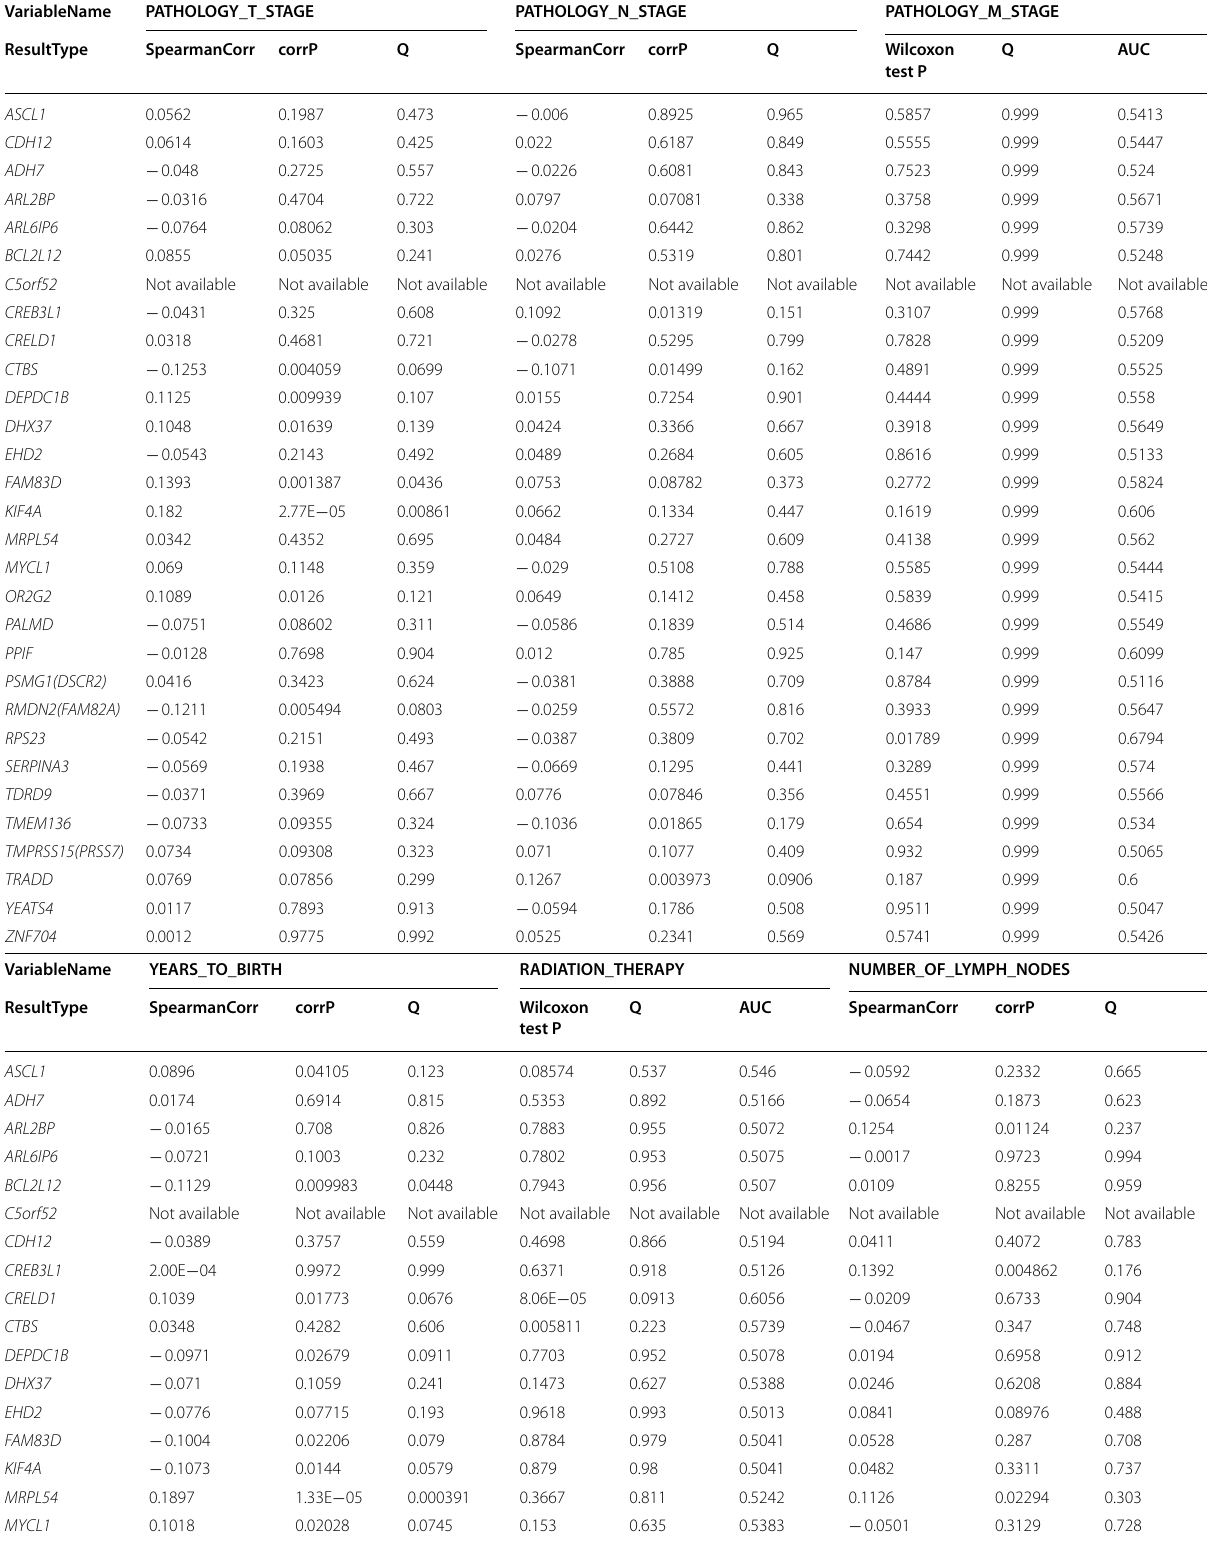
Table 2 The outcomes of FireBrowse for assessment of clinical features versus mRNA